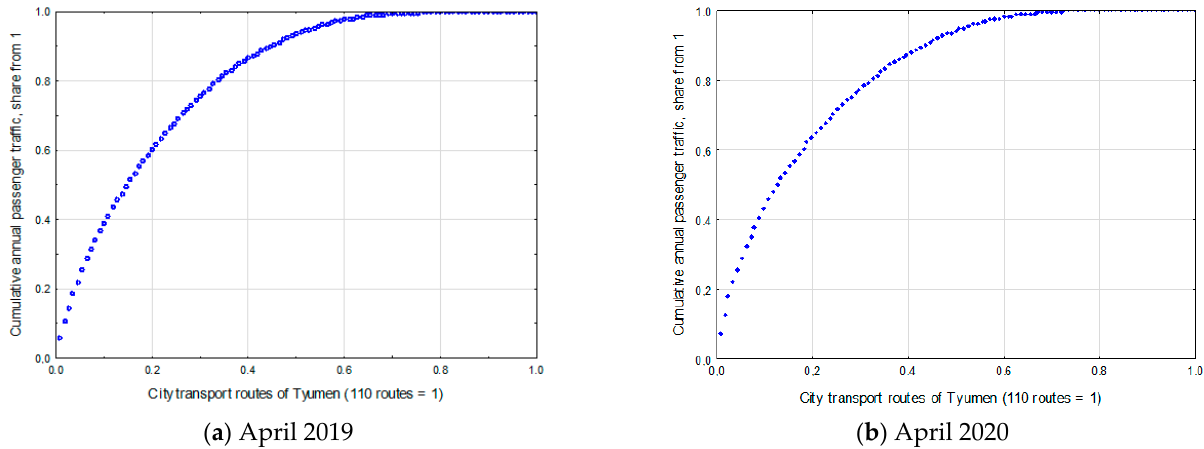
Figure 15. Pareto-distribution of cumulative transportation volume during April Q 04 at Tyumen CPPT routes. Note: scales of coordinate planes are normalized in range [0, 1].